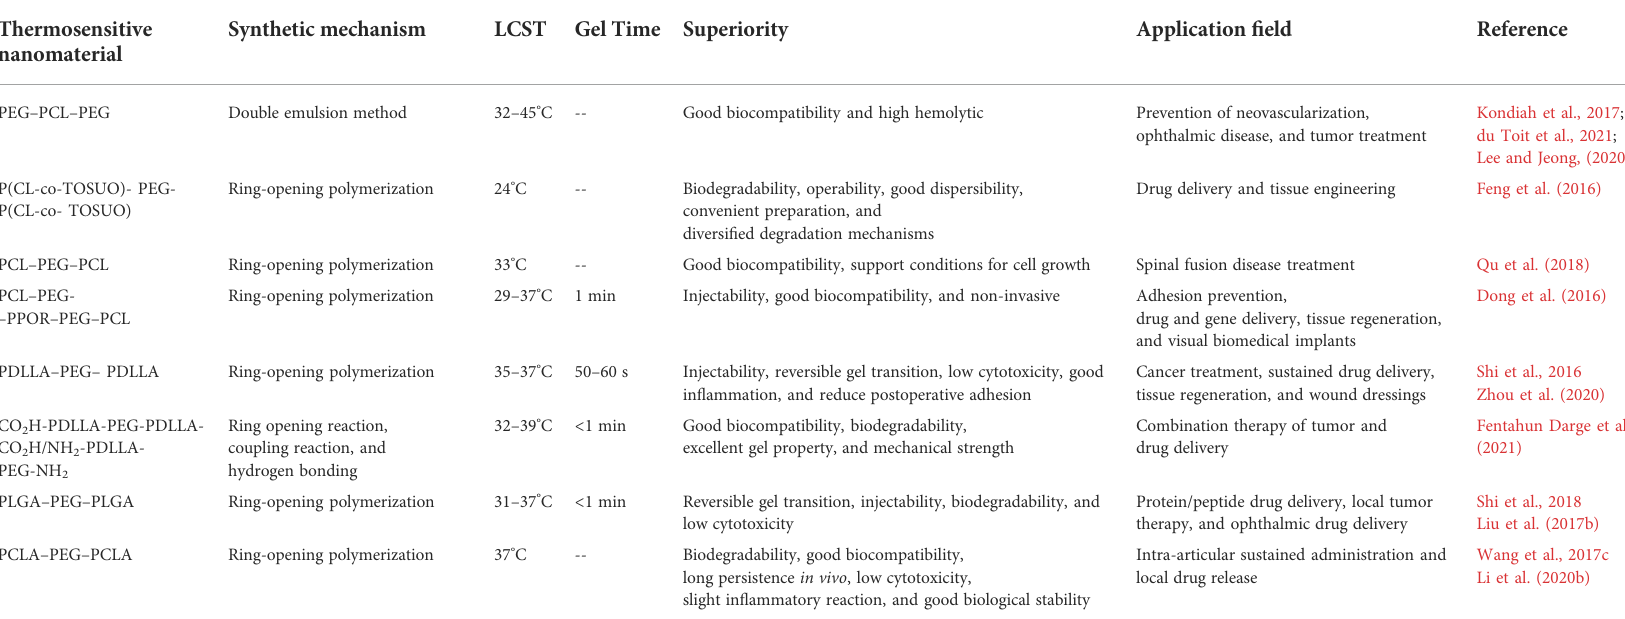
TABLE 3 List of thermosensitive nanomaterials based on